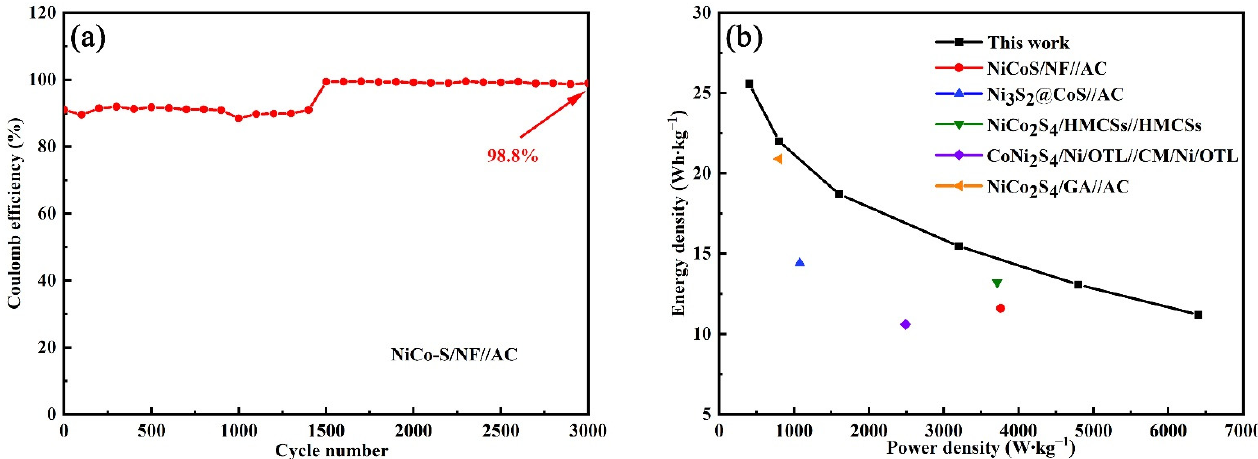
Figure 11. ( a ) Coulomb e ffi ciency of NiCo-S/NF//AC HSC at a scan rate of 50 mV·s − 1 after 3000 cycles. ( b ) Ragone plot of assembled NiCo-S/NF//AC HSC to compare the performances of other supercapacitors.